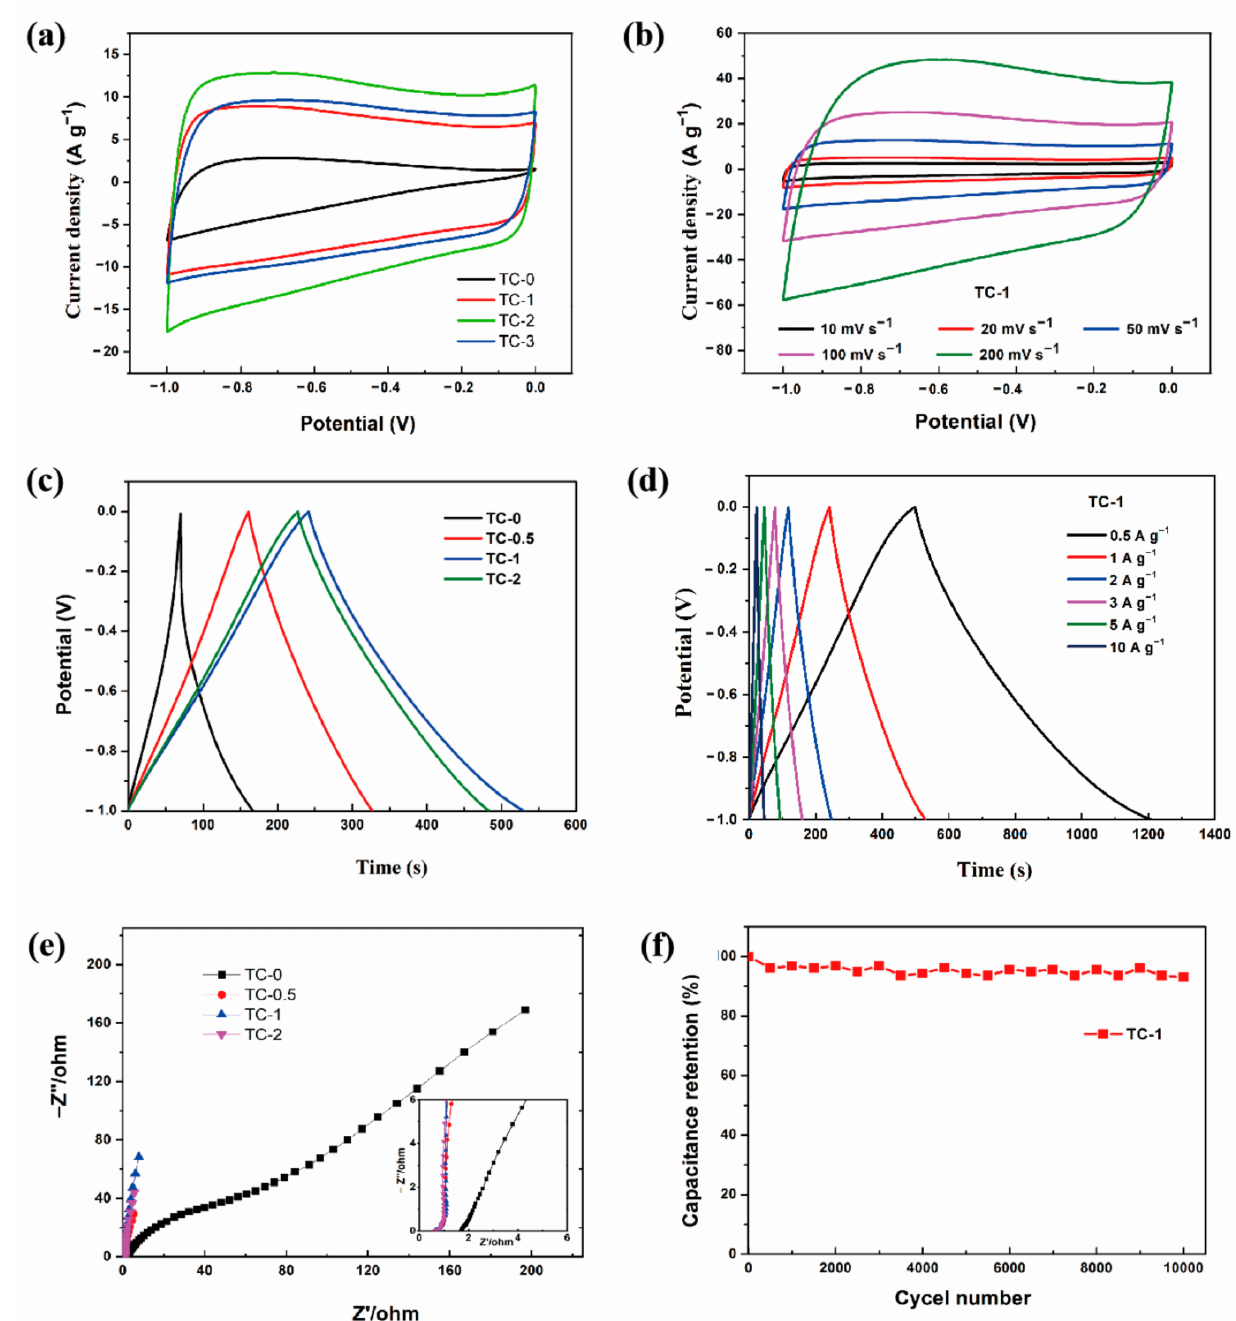
Figure 6. ( a ) Cyclic voltammetry (CV) curves at 50 mV s − 1 , ( c ) galvanostatic charge–discharge (GCD) curves at current density of 1 A g − 1 , ( e ) Nyquist plot of TC-0, TC-0.5, TC-1, and TC-2. ( b ) CV curves at various scan rates, ( d ) GCD curves at various current densities, and ( f ) capacitance retention rate of TC-1 sample in 6M